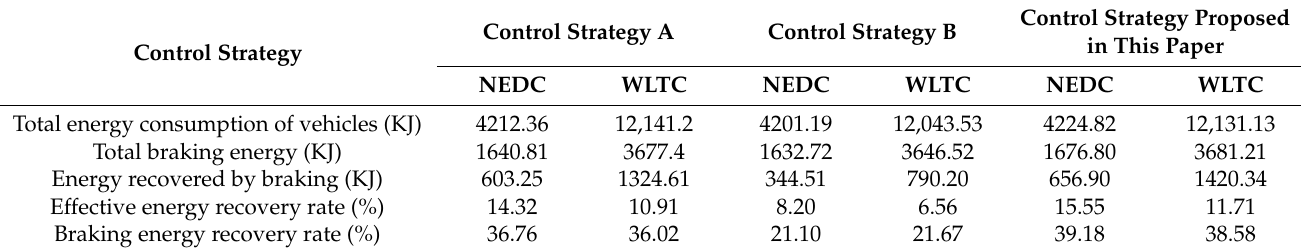
Table 3. Comparison of braking energy recovery in NEDC and WLTC